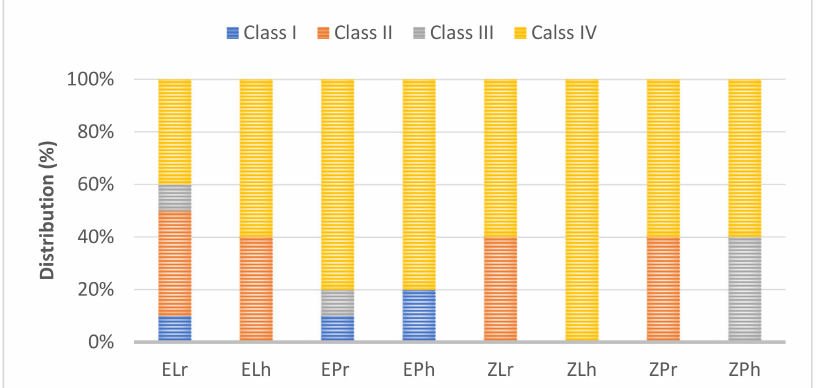
Figure 3. The mode of failure percentage (%) within study groups. Class I: Minimal fracture or crack in the restoration, Class II: Less than half of the restoration was lost, Class III: Half or more of the restoration was lost, and Class IV: Severe fracture of the restoration and/or the tooth.